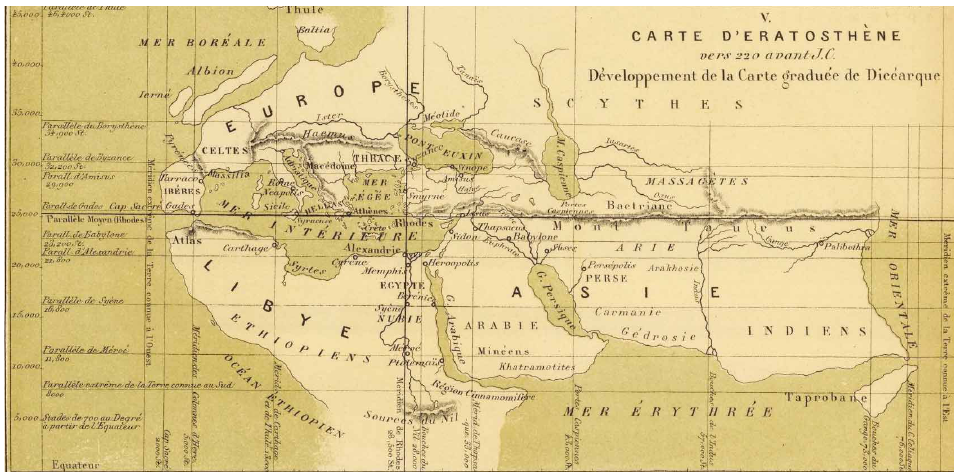
Fig. 3. Mappa mundi by